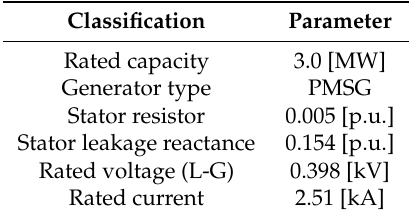
Table 2. Parameters for a PMSG-type wind turbine generator.